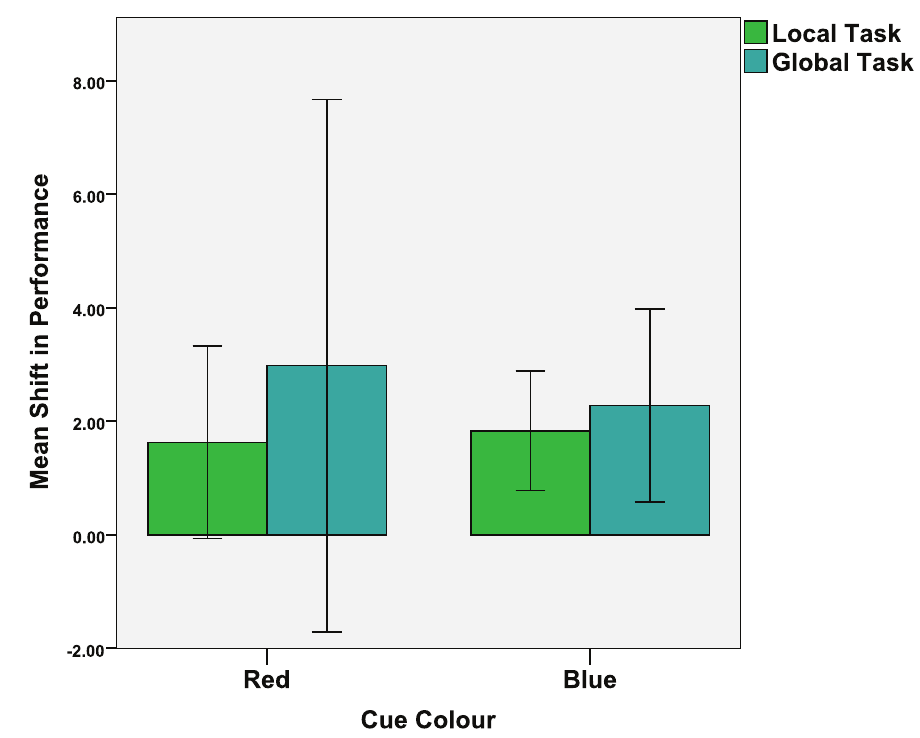
Figure 6. Mean shift-in-performance values of both the contrast (local) and coherence (global) tasks. Error bars indicate the 95% confidence interval. N.B., the error bars for the red cue condition straddle zero as some participants exhibited a negative